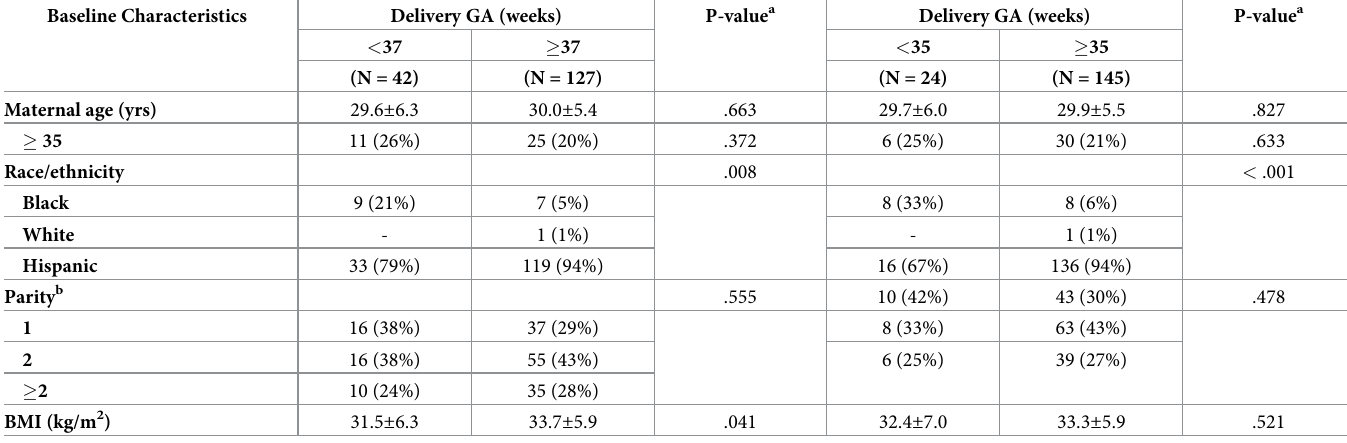
Data reported as N (%) or mean ± standard deviation. a P-value as per χ 2 for categorical and Student’s t-test for continuous variables. b Parity based on entry into pregnancy for CRH measurement. All women were at least